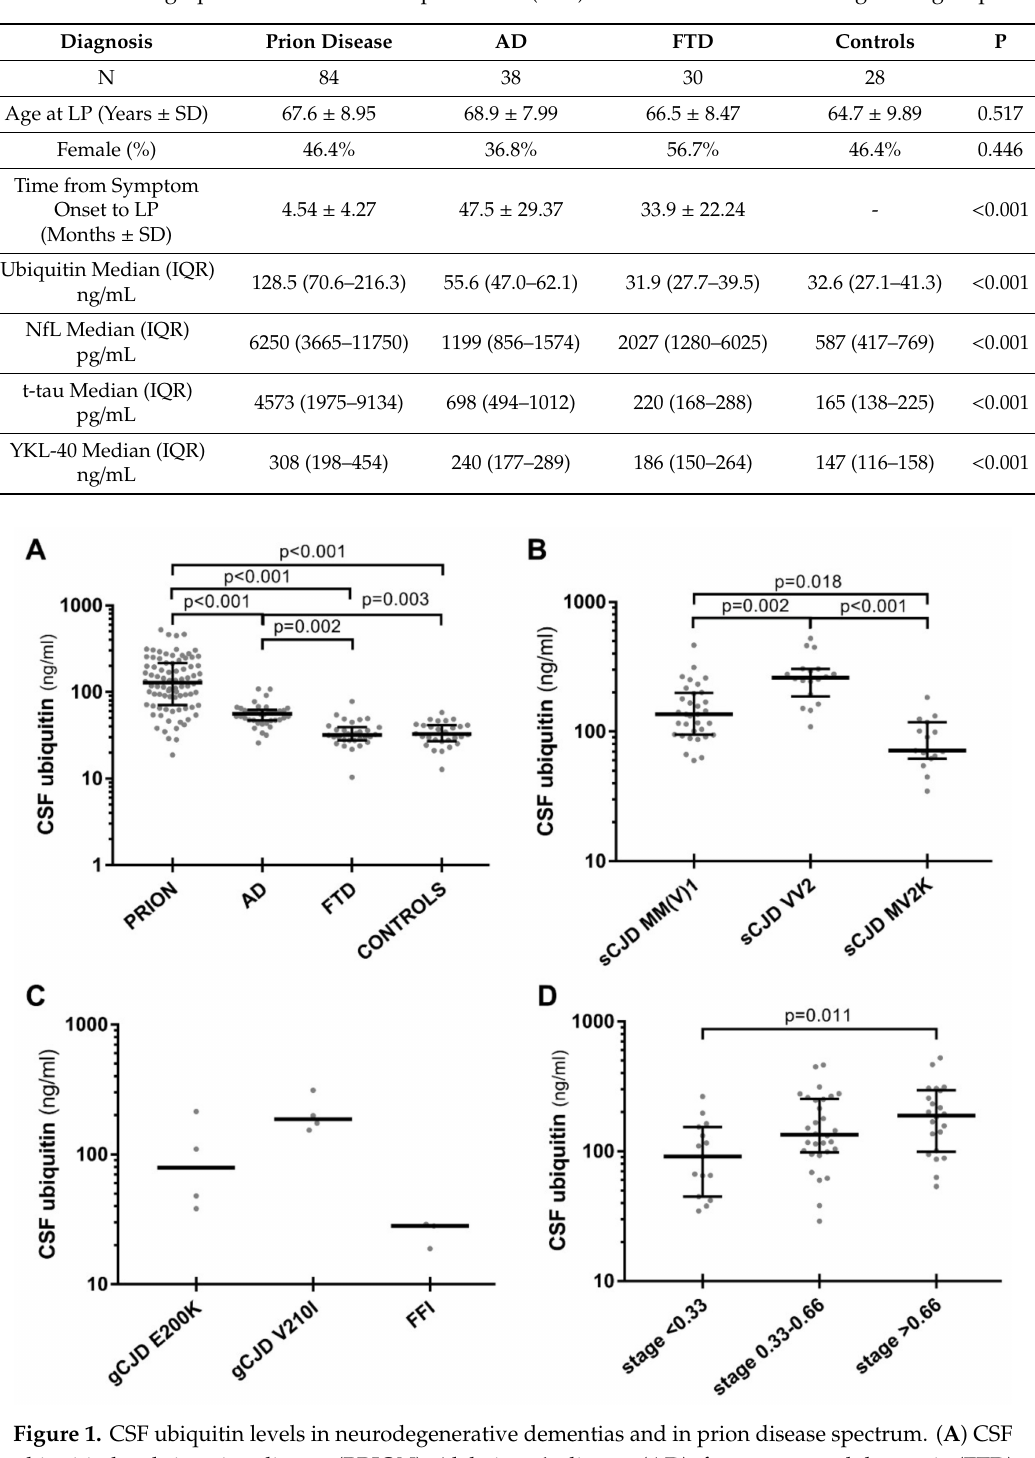
Table 1. Demographic data and cerebrospinal fluid (CSF) biomarker levels in the diagnostic groups.